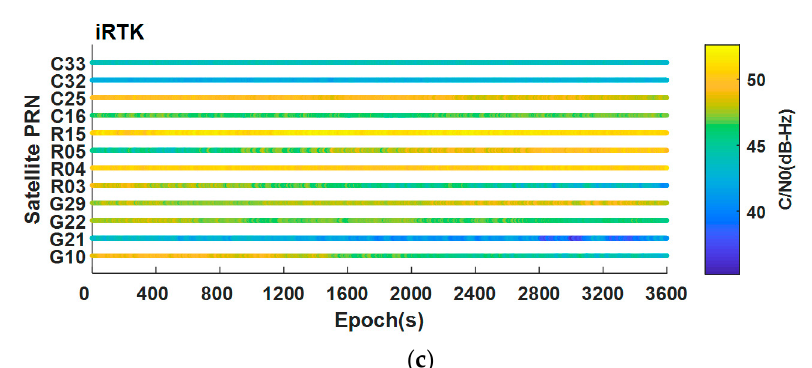
Figure 3. Continuity and the C/N0 of the GNSS raw observations from smartphones and receivers. ( a ) Continuity and the C/N0 of Xiaomi 8 A and Xiaomi 8 B; ( b ) Continuity and the C/N0 of OPPO and HUAWEI; ( c ) Continuity and the C/N0 of iRTK2.